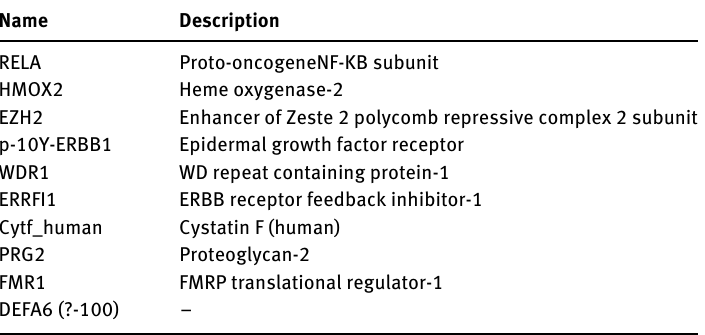
Table 7: 10 highly significant, direct and physical network associators of